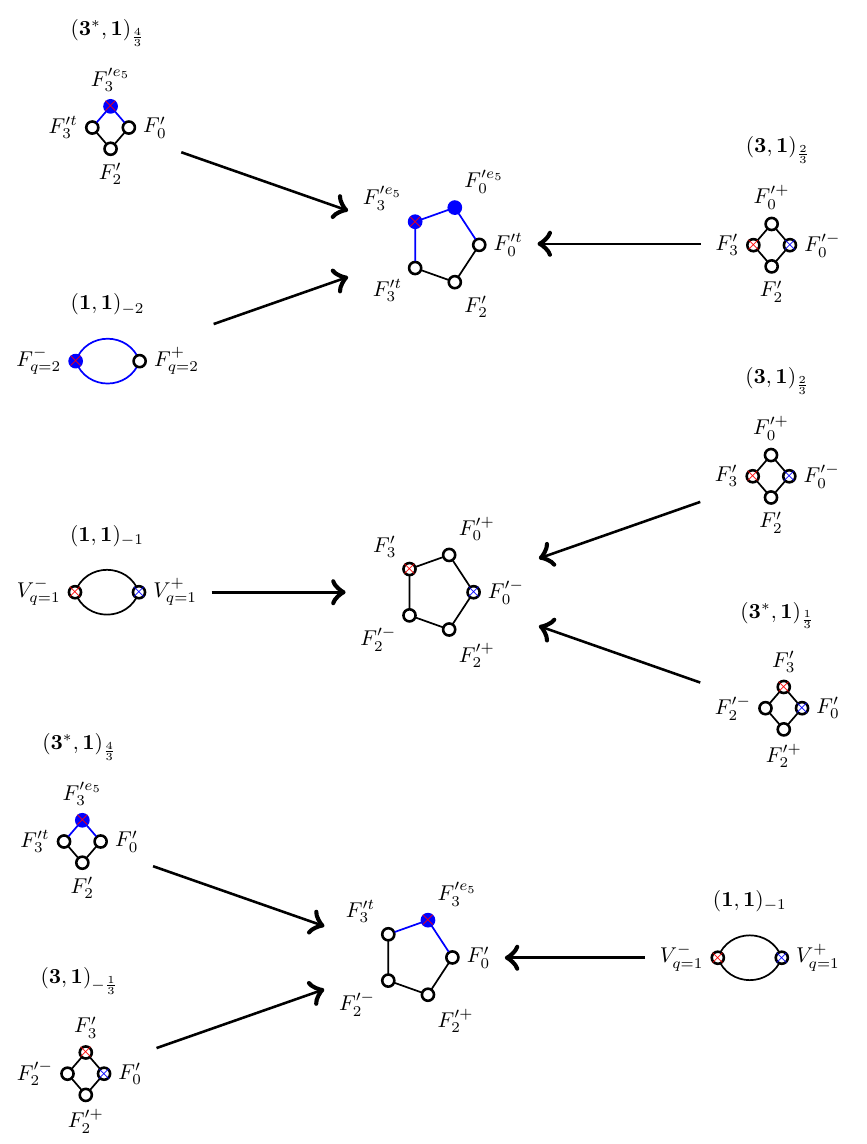
Figure 6 . Singular fibers associated to Yukawa interactions of the form ( 3 ∗ , 1 ) w ( 1 , 1 ) w 00 ¯1